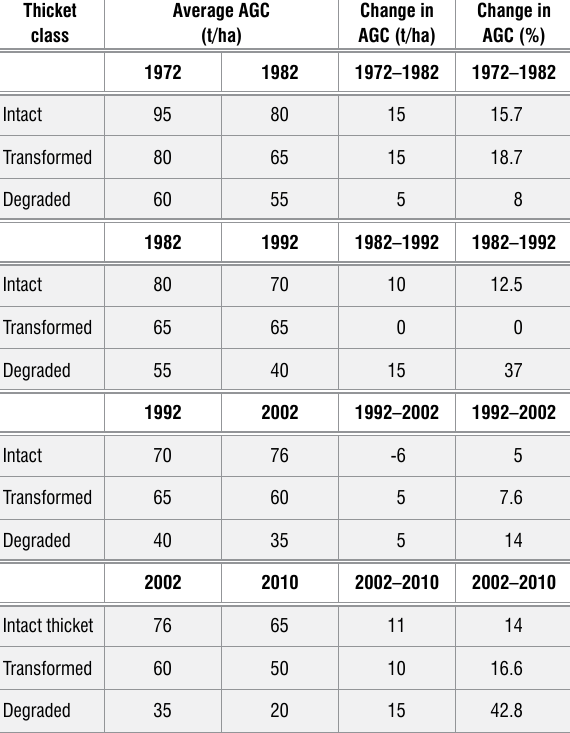
Table 1: Comparison of mean aboveground carbon (AGC) stocks between 1972 and 2010 Thicket class